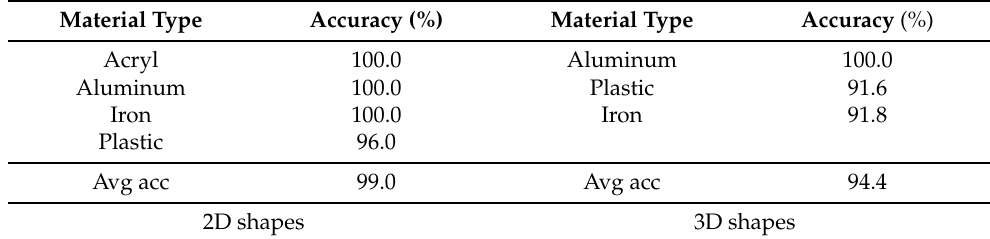
Table 3. Raw material classification with ultrasound.